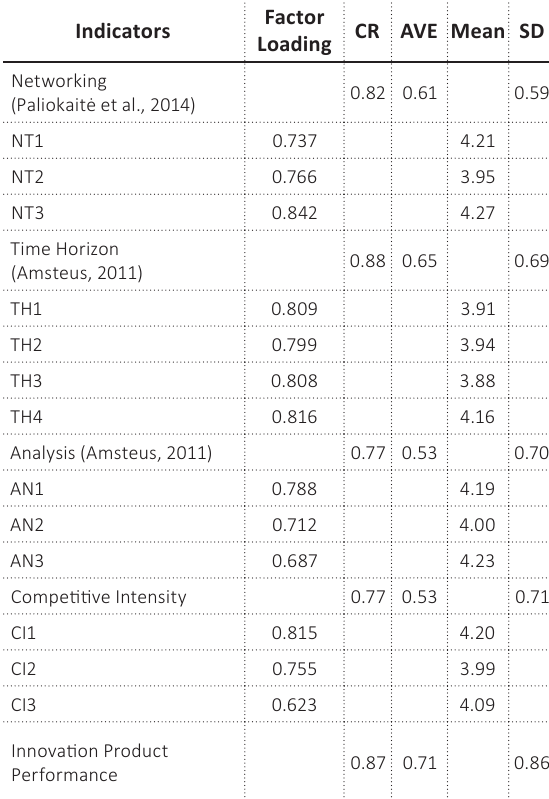
Table 2. Reliability, validity, and